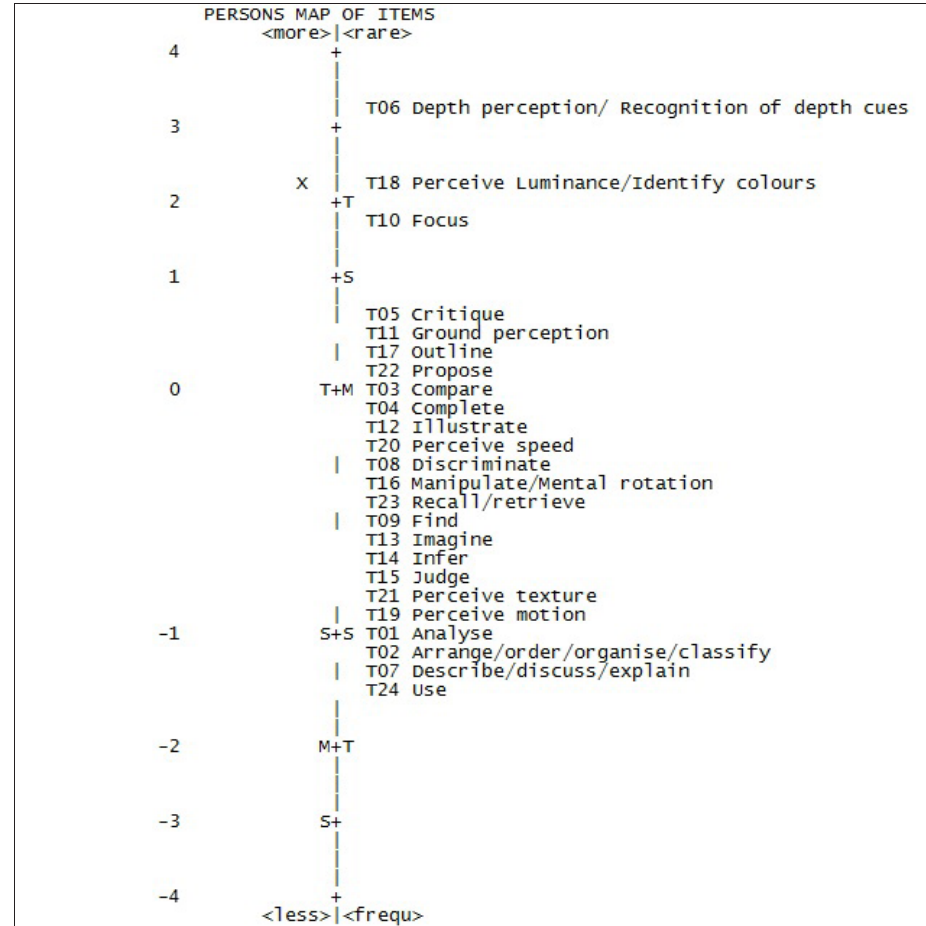
Figure 3: Item difficulty map for Campus B students ( n